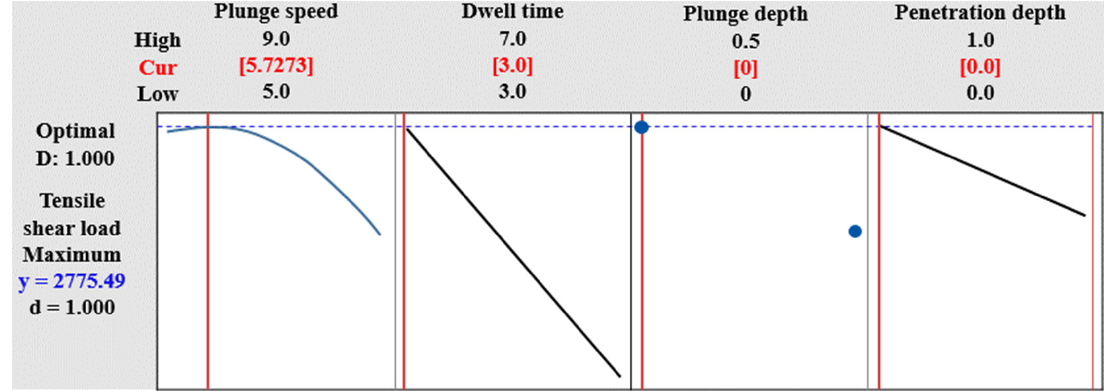
Figure 7. Response optimization of tensile shear load.